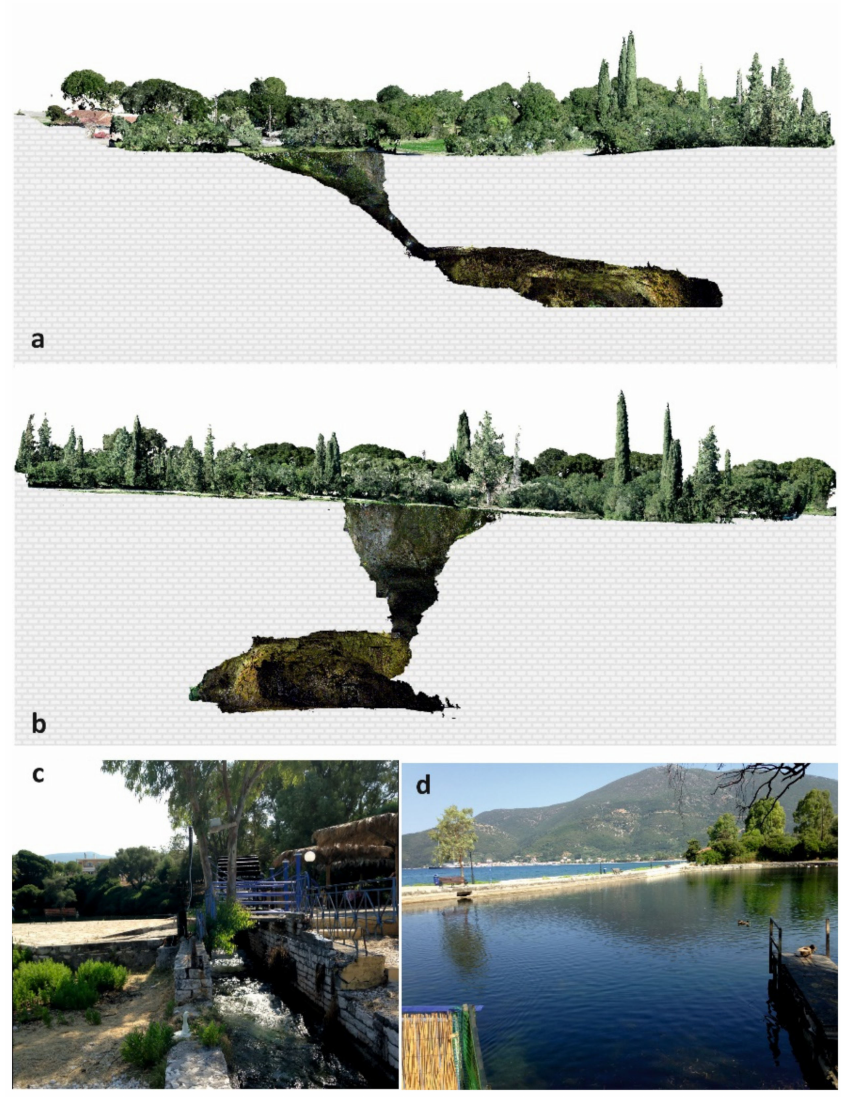
Figure 11. Selected geosites on Kefalonia island, for coding see Figure 4: ( a , b ) photorealistic represen- tation of the Drogarati cave position (K07) under the surface, in proportional scale, produced after the combined point cloud originated from Terrestrial Laser Scanner and Unmanned Aerial System data processing; ( c , d ) Karavomylos spring and the artificial lake (K04). Photos courtesy ( a , b ) E. Vassilakis, ( c , d ) M. V.